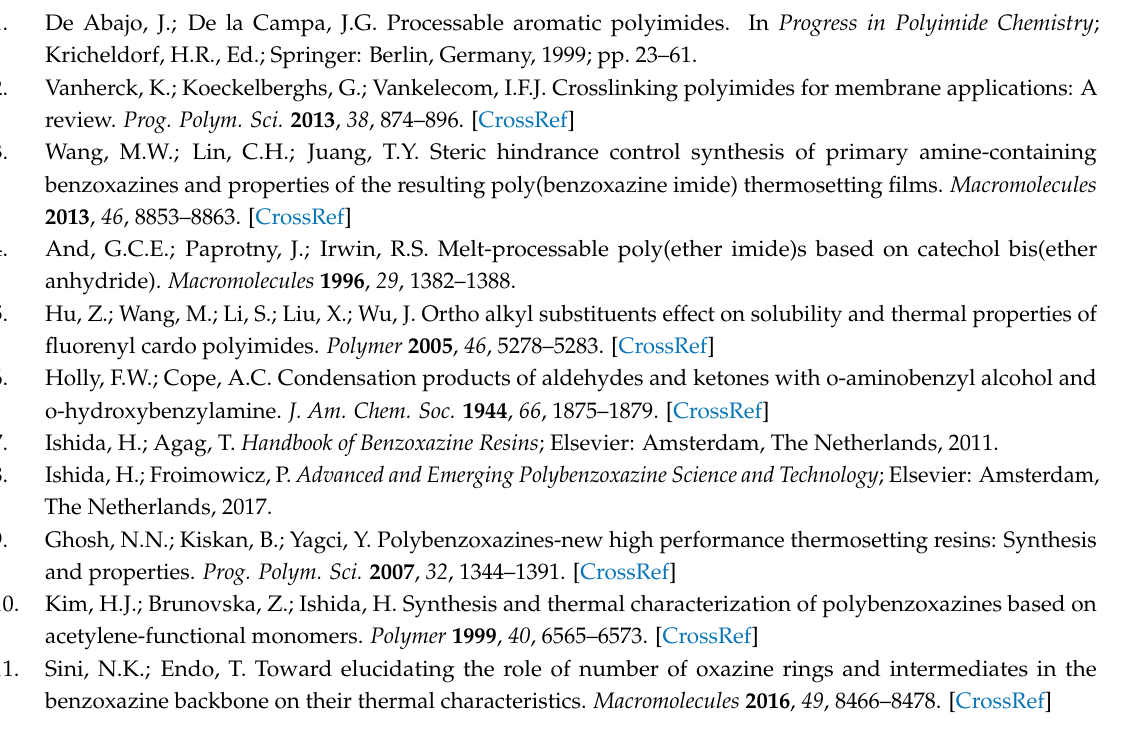
Figure S1. 1 H- 13 C HMQC 2D NMR spectrum for o MHI-a, Figure S2. 1H-13C HMQC 2D NMR spectrum of o HHI-a, Figure S3. 1H-13C HMQC 2D NMR spectrum of o HTI-a, Figure S4. FTIR spectra of benzoxazine